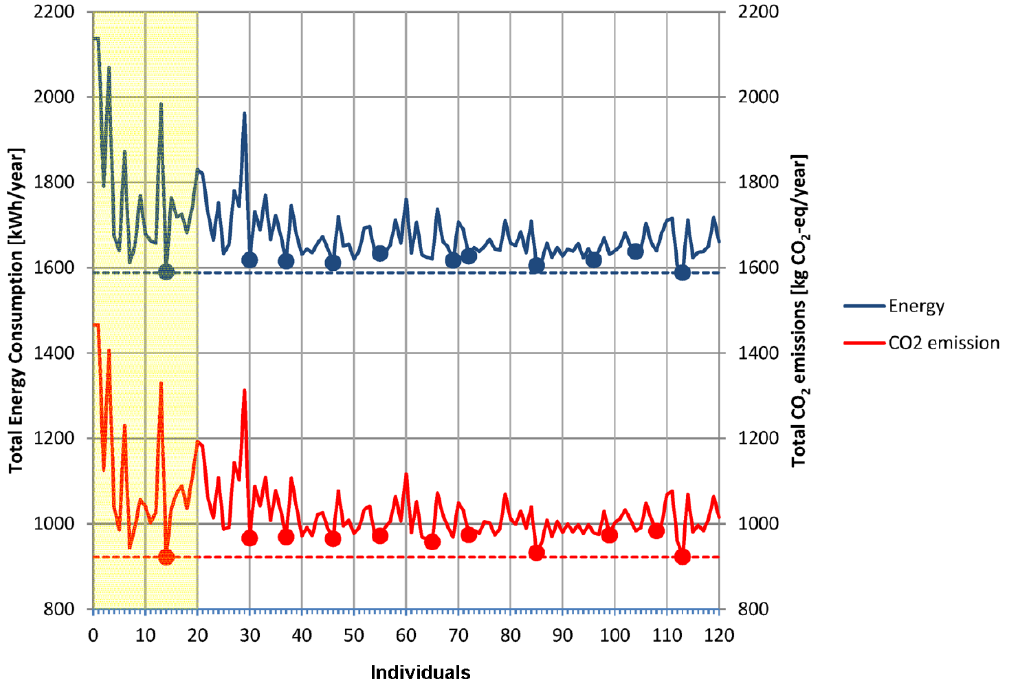
Figure 7. Outcomes of the optimization